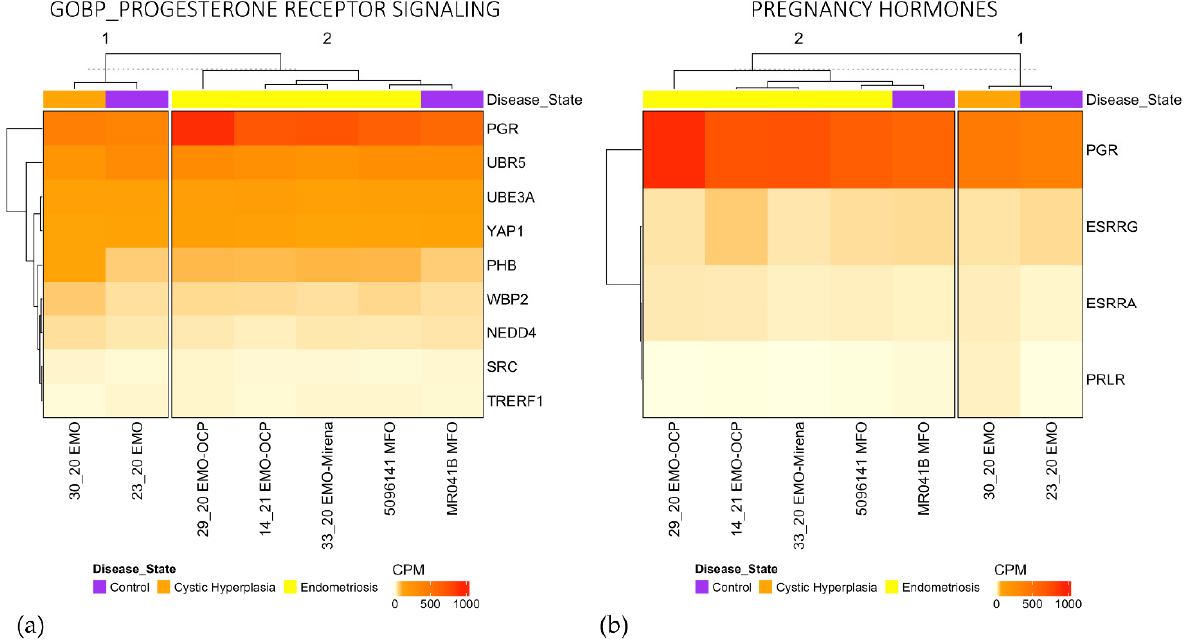
Figure 5. Heatmaps for Progesterone Receptor Signaling ( a ) and Pregnancy Hormones ( b ) show clustering of EMO.